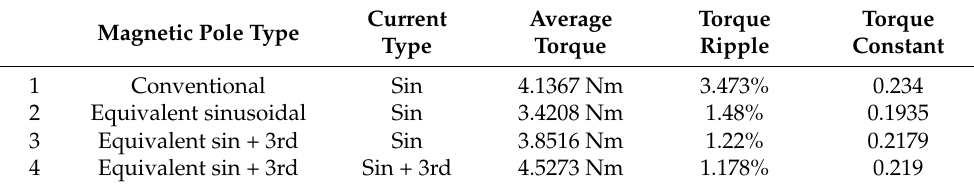
Figure 15. Comparison of torque changes before and after current harmonic injection. Table 9. Performance comparison of dual three-phase